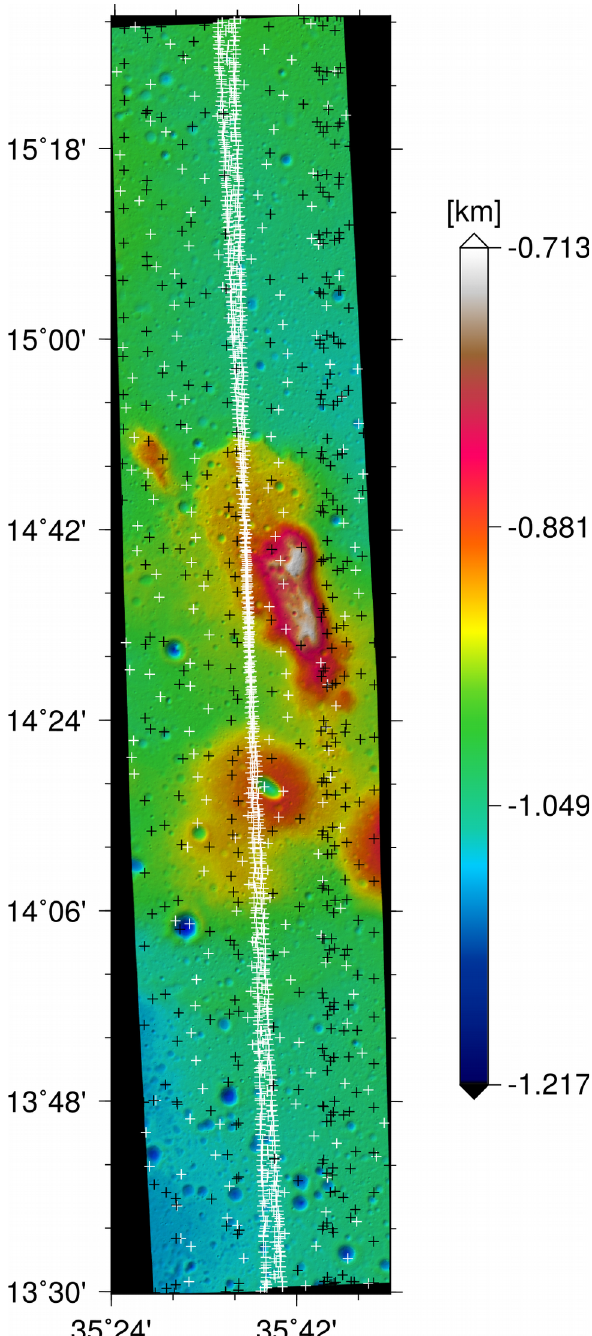
Figure 1: Initial 3 m DTM (shaded and color-coded) showing the locations of the LOLA ground control points (black plus signs) and the image tie points (white plus signs) used in the BA. Elevations refer to the mean lunar radius of 1737.4